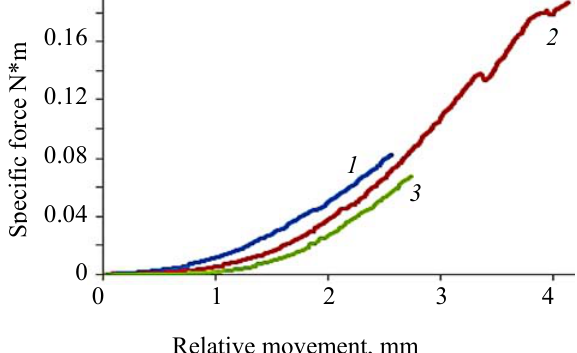
Fig. 4. Loading curves for the cutting of carrots samples after 3 months of storage ( 1 ) Nantes carrots, ( 2 ) Forto carrots, ( 3 ) Toucheon